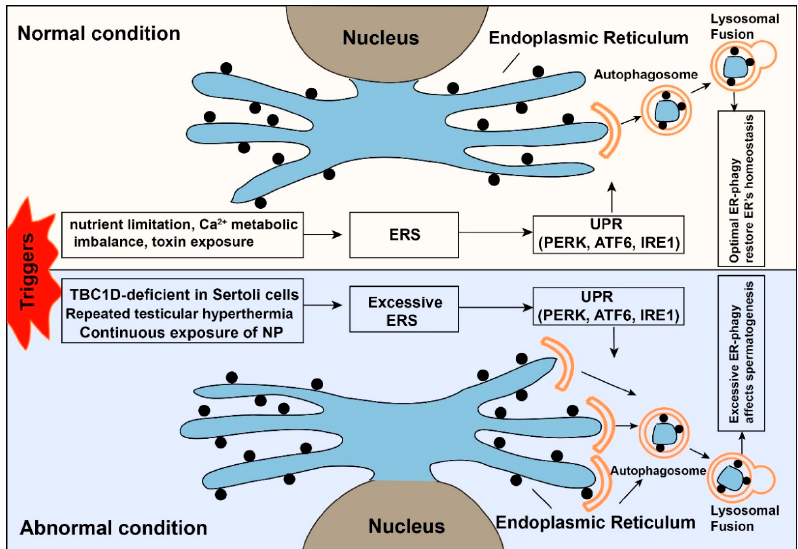
Figure 4. The dual role of endoplasmic reticulum autophagy. When cells face external stimuli, many protective mechanisms will be activated to restore the cells’ homeostasis. The upper panel shows endoplasmic reticulum stress (ERS) is a protective mechanism under normal conditions. The ubiquitin-proteasome system (UPS) and ER-phagy will be activated after the emergence of ERS. The normal function of ER and homeostasis of the cell will be restored. While the lower panel shows that under abnormal conditions, the intense or prolonged triggers ( TBC1D20 -deficient Sertoli cells of male mice, continuous exposure of nonylphenol, repeated testicular hyperthermia) will cause excessive ER-phagy, which affects the normal spermatogenic process.